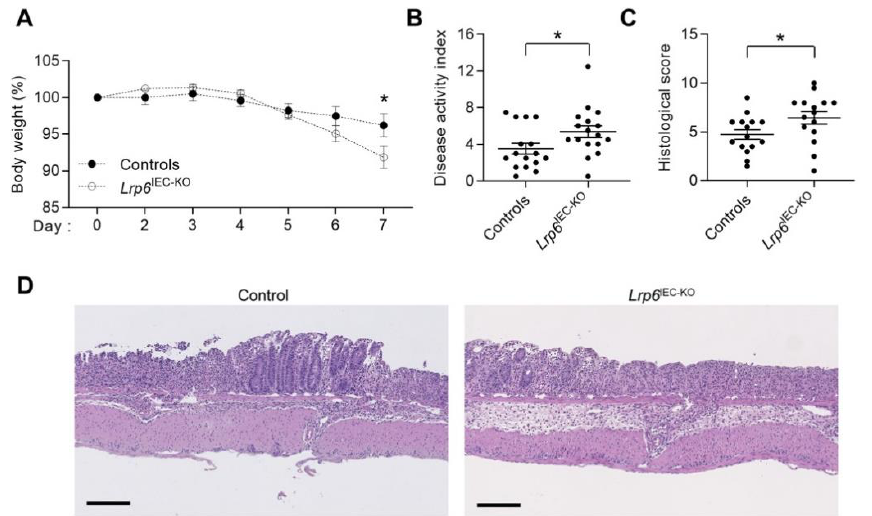
Figure 3. Lrp6 IEC-KO mice are more sensitive to DSS-induced colitis. Ten- to twelve-week-old Lrp6 IEC-KO and control mice were treated with 1.75–2% DSS in water for 7 days. ( A ) Body weight was measured every day ( n = 18). ( B ) Disease activity index of Lrp6 IEC-KO and control mice was calculated by scoring stool softness, occult fecal blood, rectal bleeding and colon rigidity at euthanasia ( n ≥ 15). ( C , D ) H&E staining was performed on Lrp6 IEC-KO and control colon tissues to score damage ( C ) according to the extent of mucosal architecture destruction, immune cell infiltration, goblet